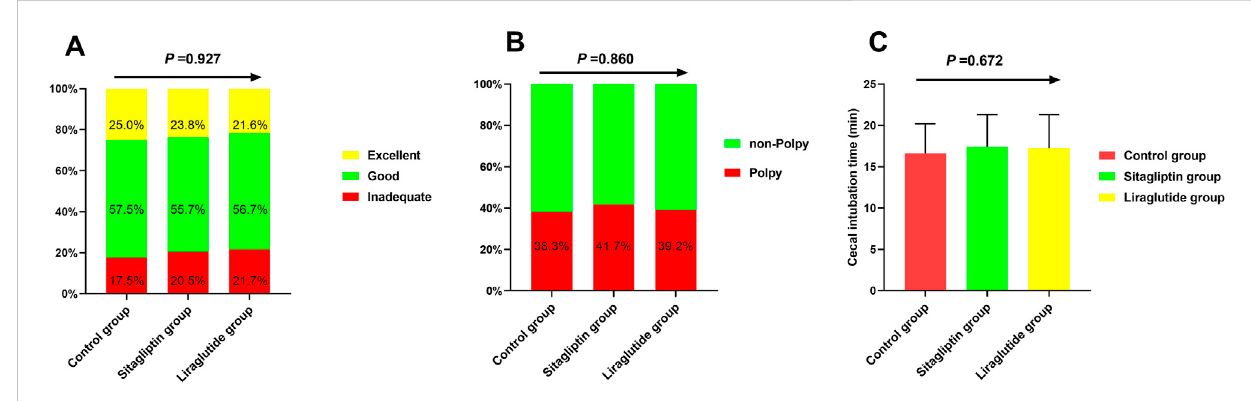
FIGURE 2 The incidence of inadequate bowel cleaning (A) , polyp-detecting rates (B) , and cecal intubation time (C) among the three